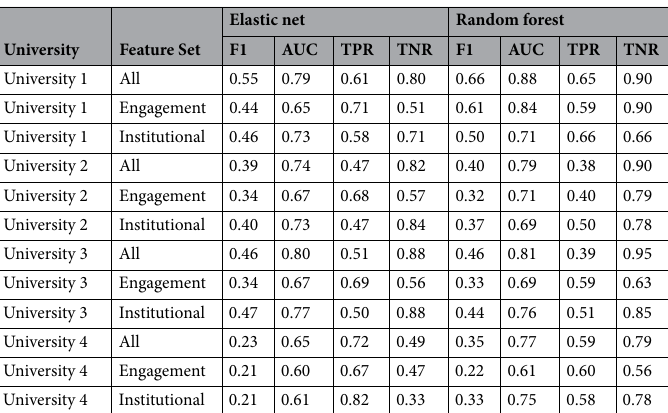
Table 2. Indicators of predictive performance across different universities, models, feature sets and performance metrics. F1 F1 score, AUC Area under ROC-curve, TPR True positive rate, TNR True negative rate. By setting the predicted outcome to the majority class, the featureless baseline learner produces F1 = 0, AUC = 0.5, TPR = 0 and TNR = 1 across all